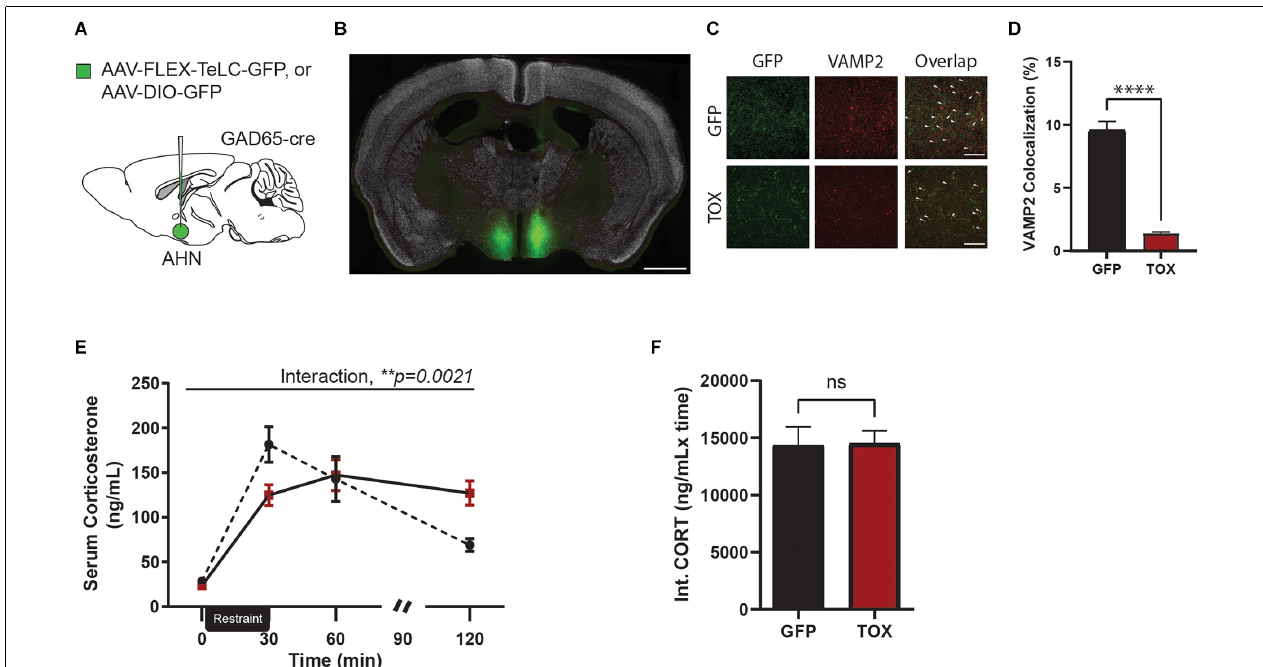
FIGURE 4 | AHN GABAergic synaptic functional loss induced disruption of negative feedback of HPA-axis. (A) A cartoon diagram demonstrating experimental approach to AHN GABA synaptic function loss. (B) A representative image of AHN with AAV-FLEX-TeLC-GFP. Green, TOX. White, NeuN. Scale bar = 1 mm. (C) Comparison of Vamp2 expression in AHN GABA synaptic terminals, 20x confocal microscope images in GFP (first row) and TOX (second row) mice. Left, GFP positive AHN GABA synaptic terminals. Center, Vamp2 expression. Right, an overlap of GFP and VAMP2 expression. White arrow denotes signal colocalization. Scale bar = 20 µ m. (D) VAMP2 and GFP colocalization (%) was significantly reduced in synaptic terminals of TOX treatment compared to those of the GFP (GFP N = 5, TOX N = 5, unpaired t -test, t = 12.05, df = 157, ∗∗∗∗ p < 0.0001). (E) Chronic inhibition of AHN GABAergic synapses results in impaired peak CORT release and led to prolonged CORT exposure in TOX mice but not in GFP mice (2-WAY RM ANOVA, time × AHN treatment, F (3,30) = 6.189, ** p = 0.0021, time effect, F (3,30) = 38.05, ∗∗∗∗ p < 0001, AHN treatment effect, F (1,10) = 0.000209, p = 0.9888, NS, Bonferroni’s multiple comparisons test, t = 0 GFP vs. TOX, p > 0.9999, NS, t = 30 GFP vs. TOX, * p = 0.0314, t = 60 GFP vs. TOX, p > 0.9999, t = 120 GFP vs. TOX, * p = 0.0266, Bonferroni’s multiple comparisons test across time,